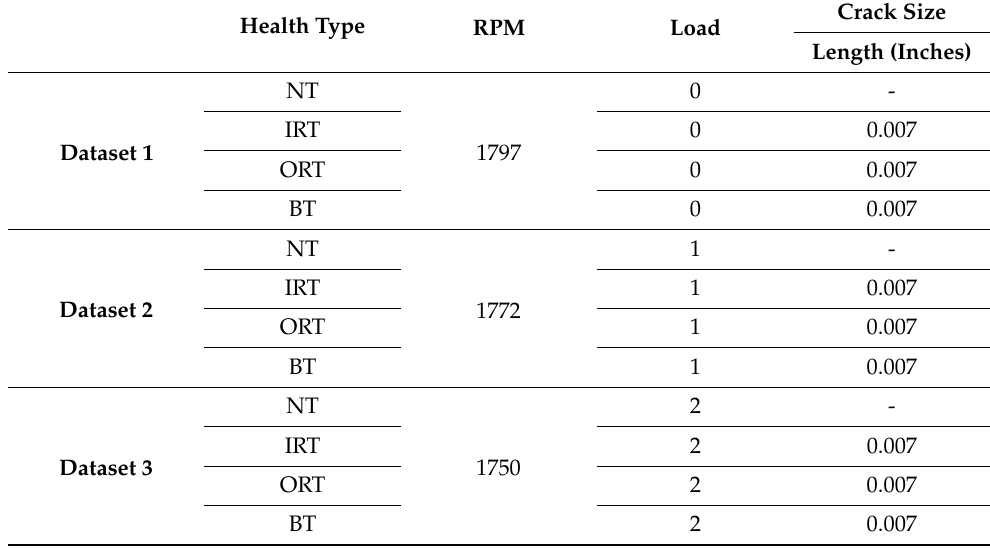
Figure 12. CWRU bearing testbed [66]. Table 5. Dataset for case study 2.